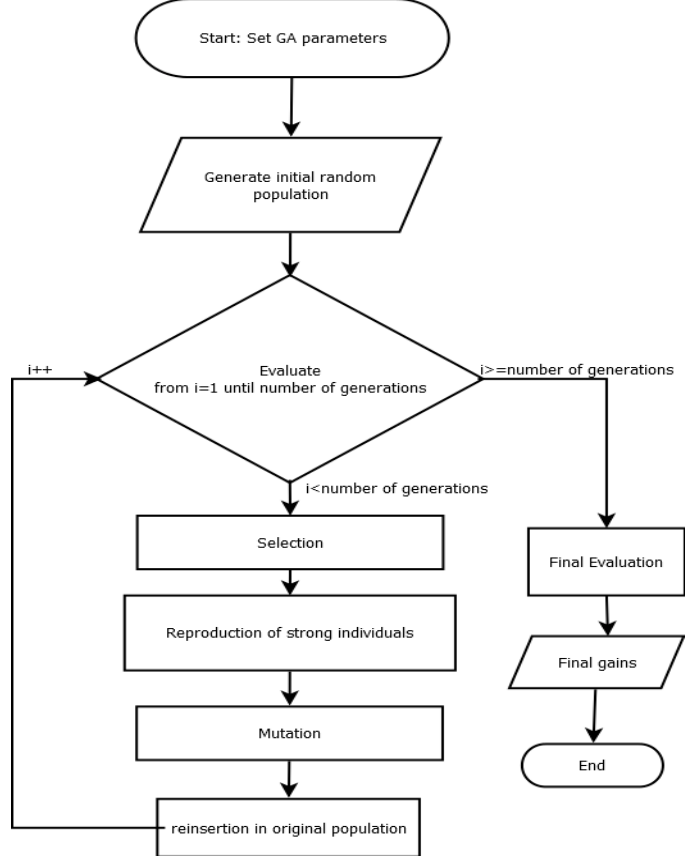
Figure 4. Flowchart of the genetic algorithm used. Table 1. Parameters of the genetic